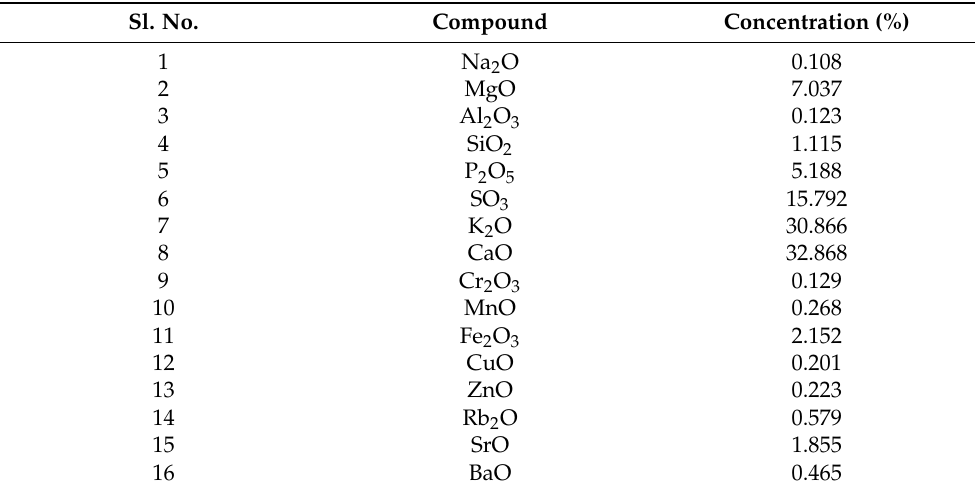
Table 1. Determination of orange peel ash (OPA) composition using X-ray fluorescence (XRF) analysis. Sl.